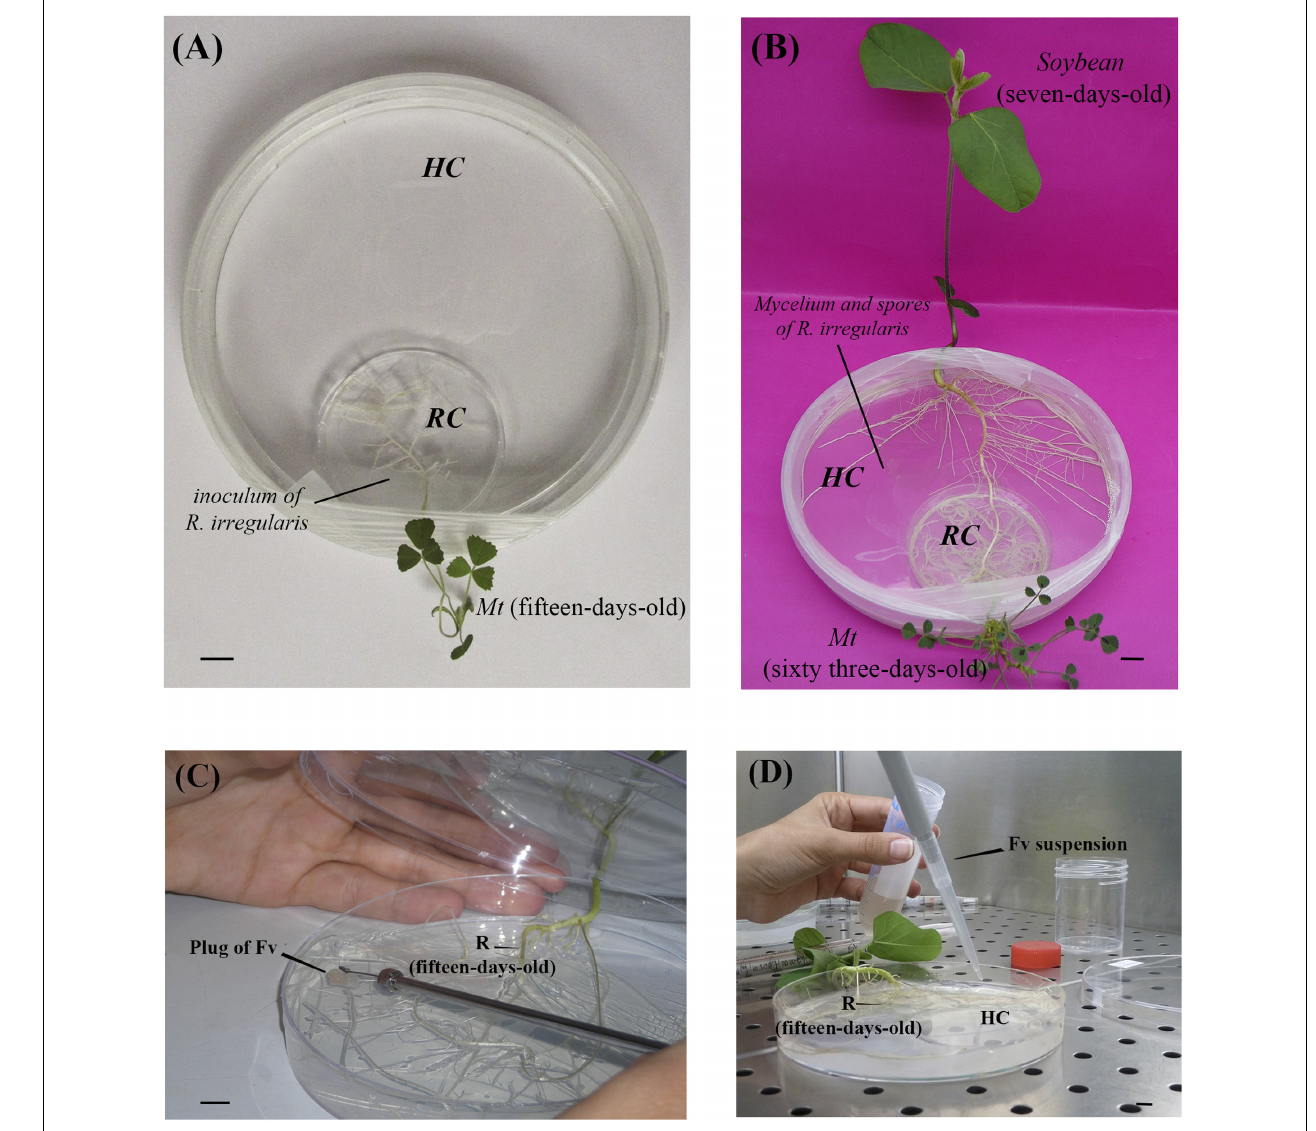
FIGURE 1 | Mycorrhizal Donor Plant (MDP) in vitro culture system for the mycorrhization of Medicago truncatula ( Mt ) and subsequent infection by Fusarium virguliforme [adapted from Voets et al. (2009) and Anene et al., 2013]. (A) Bi-compartmented in vitro culture system with a root compartment (RC) and a hyphal compartment (HC). A plant of M. truncatula (15-days-old) is inserted in the RC and associated to the arbuscular mycorrhizal fungus (AMF) Rhizophagus irregularis MUCL 41833. Bar = 1 cm. (B) Soybean plantlet (7-days-old) inserted in the HC, with the roots in direct contact with the extraradical mycelium of R. irregularis – Bar = 1 cm. (C) Root (R) of soybean plants (15-days-old) infected with a plug of Potato Dextrose Agar (PDA) (25 mm 2 ) covered with F. virguliforme (method 1). Bar = 1 cm. (D) Roots of s oybean plantlets (15-days-old) infected with a 2 ml suspension of 1.52 × 10 6 macroconidia/ml of F. virguliforme (method 2) – Bar = 1 cm.